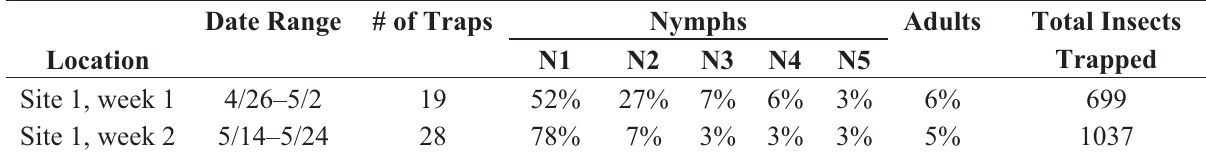
Table 1. Proportion of life stages trapped during two separate weeks at Study Site 1.